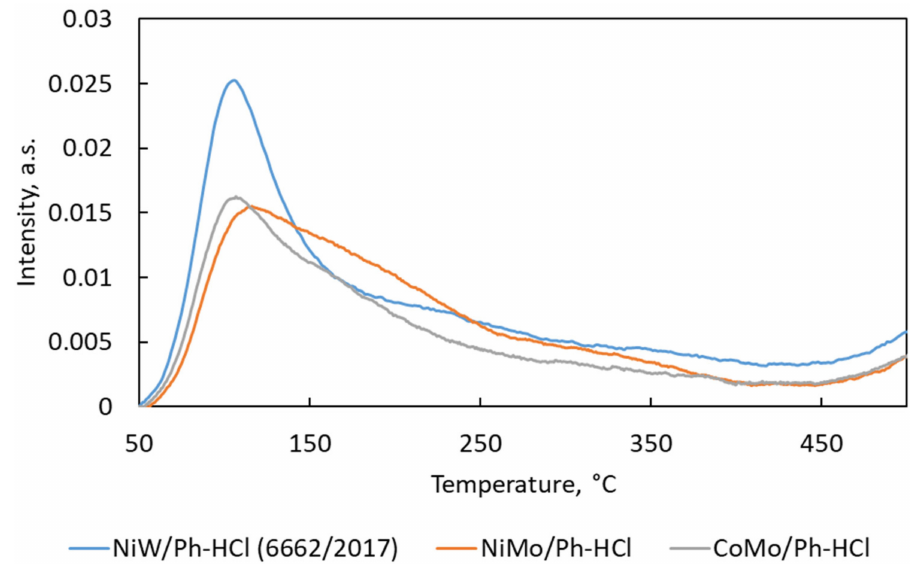
Figure 4. CO 2 -TPD profiles for all the catalysts.